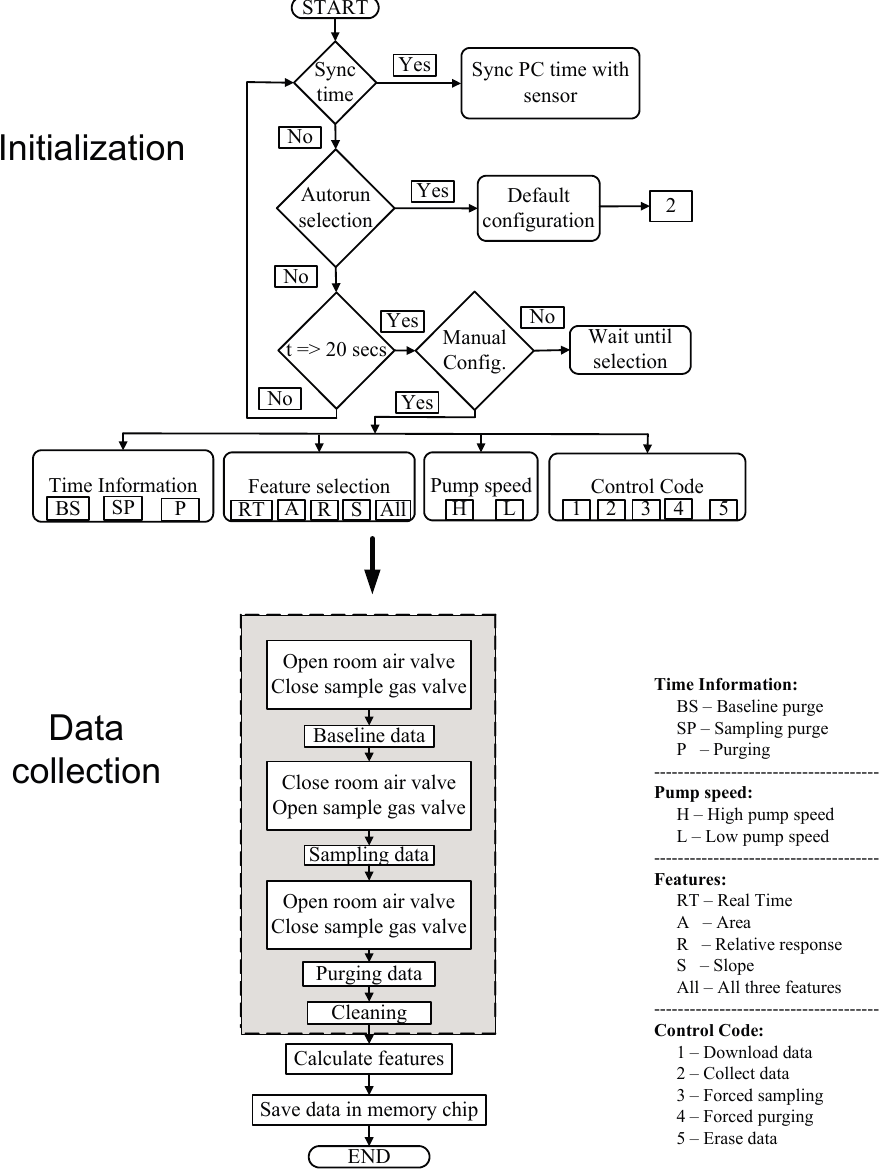
Figure 6. Flowchart of the microcontroller program used for device